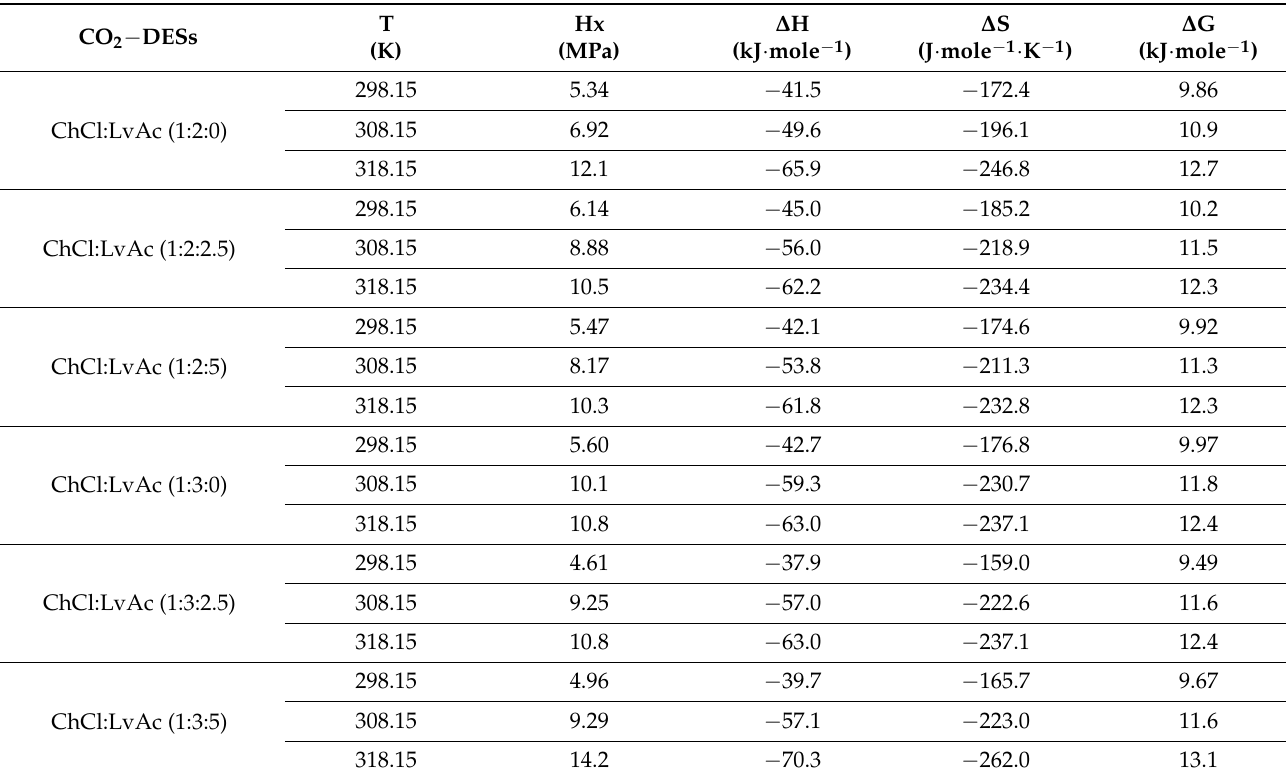
Figure 3. The CO 2 absorption capacity of ChCl:LvAc vs. MEA 30% wt. at 25 °C. Table 2. Calculated values of Henry’s law constant, enthalpy change, entropy change and change in Gibbs free energy of CO 2 − DESs at 1